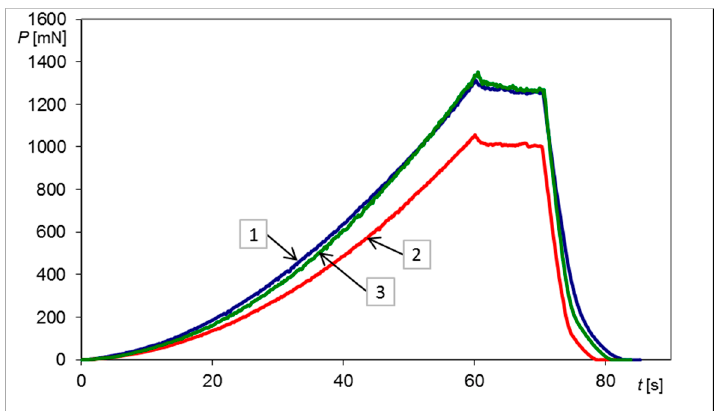
Figure 3. Three indentation test histories P – t performed to reach a penetration depth h* = 4 μ m with a Vickers probe for a circular sample made of X20Cr13 steel, where: (1) simply supported plate, no bending—blue line, (2) after first loading—red line (plate deflection Δ U 1 = 81.8 μ m), (3) after no bending—blue line, (2) after first loading—red line (plate deflection ∆ U 1 = 81.8 µ m), (3) after unloading—green line (permanent deflection Δ U 2 = 22.3 μ m). unloading—green line (permanent deflection ∆ U 2 = 22.3 µ